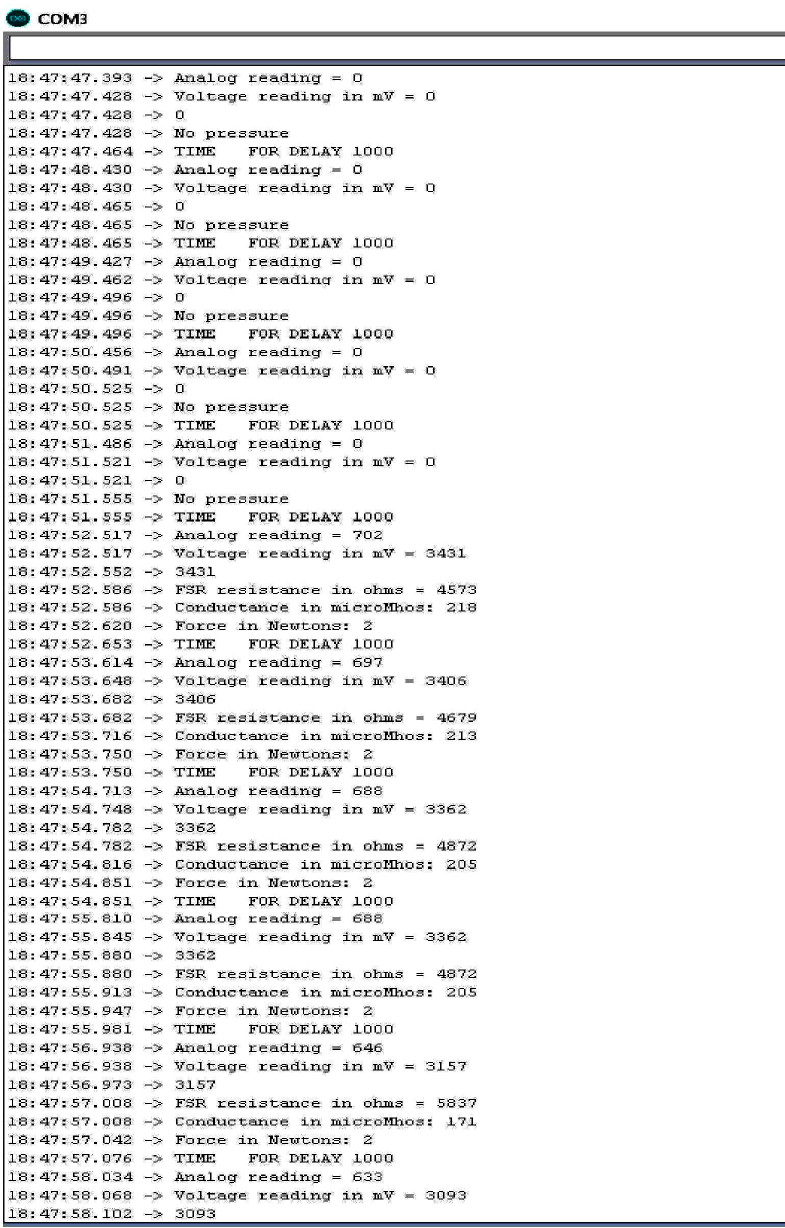
Figure A3. Application software for gripping force measurement.